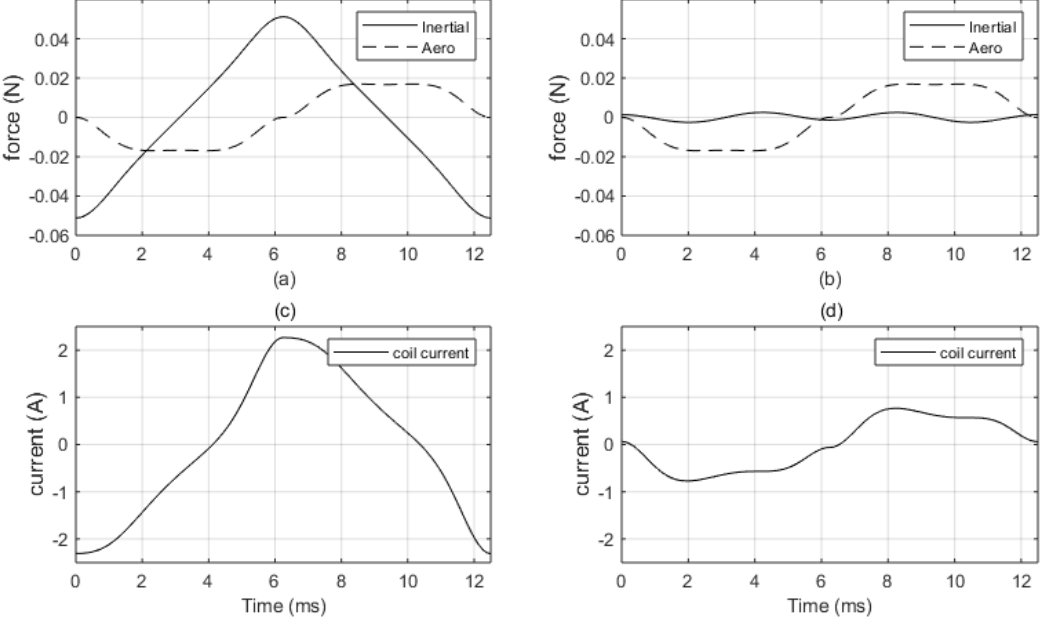
Figure 5. ( a ) Actuator force requirement in the non-resonant state. ( b ) Actuator force requirement when tuned for resonance. ( c ) Required current to operate in the non-resonant state. ( d ) Required current to operate when tuned for